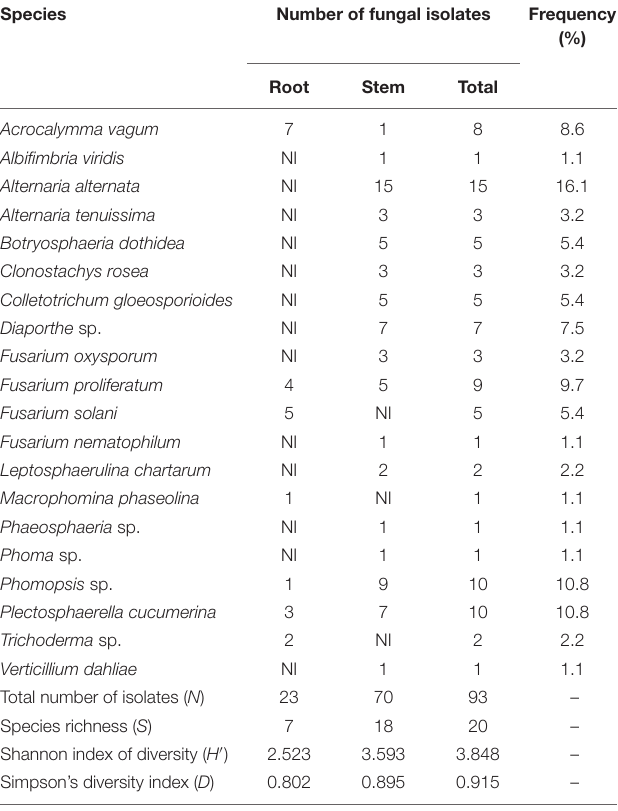
TABLE 3 | Control effects of the five antagonists of controlling cotton Verticillium wilt in